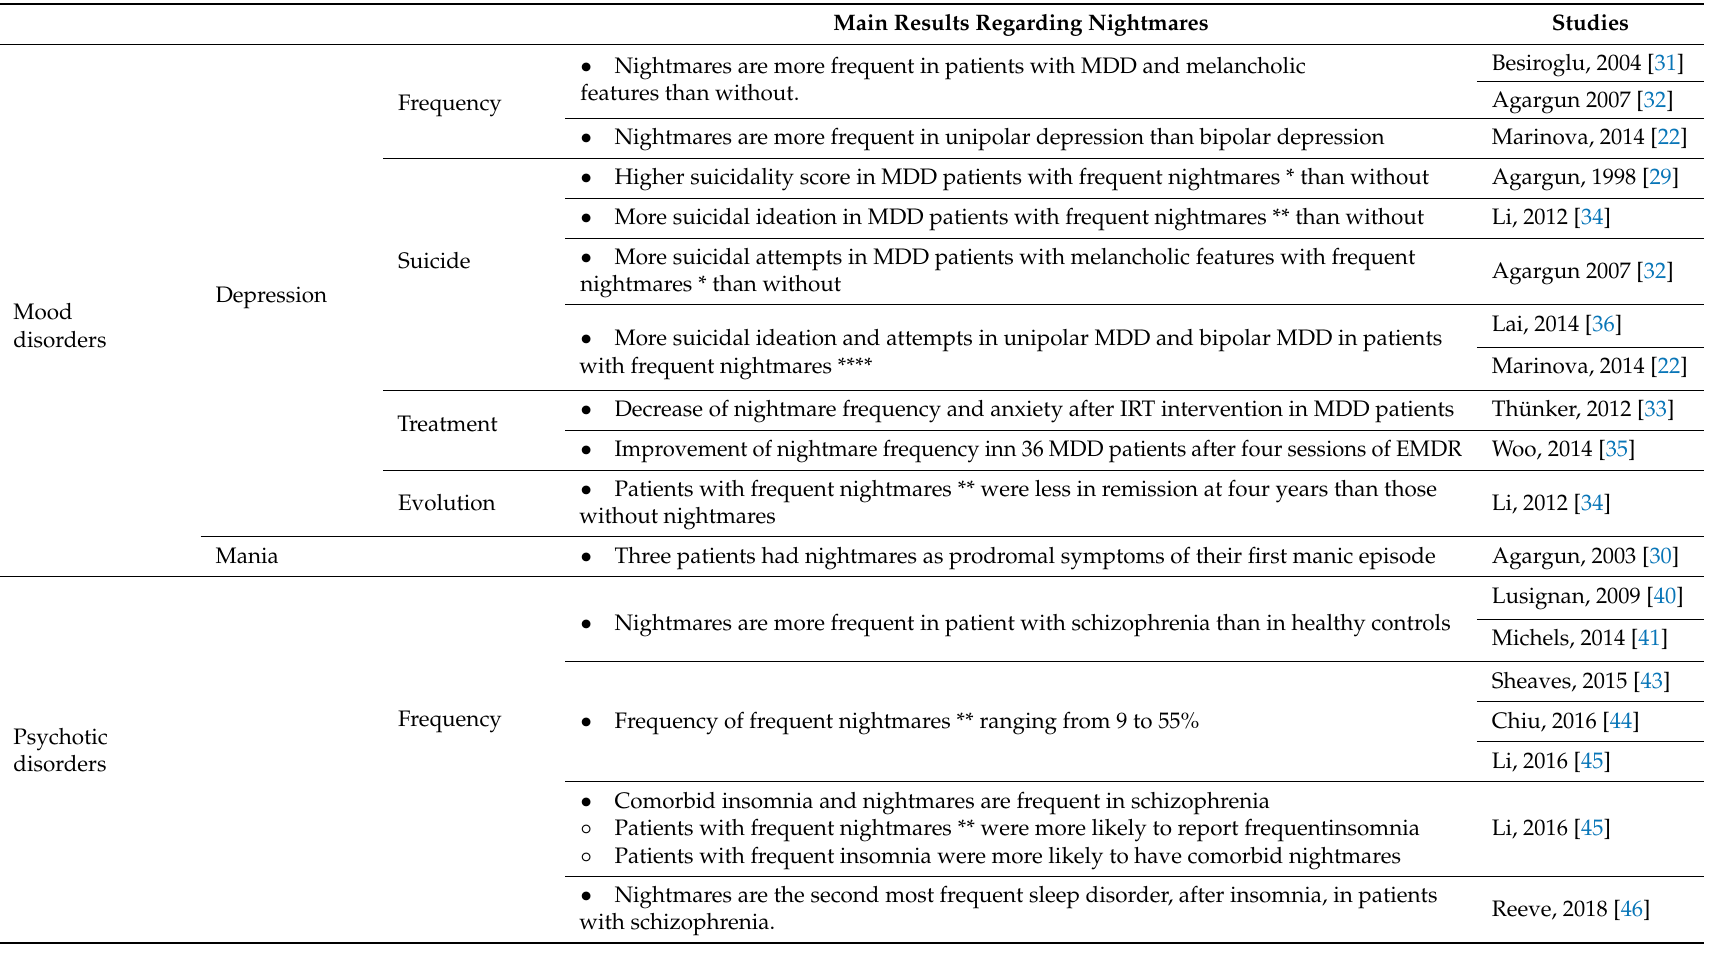
Table 4. Synthesis of the findings from the